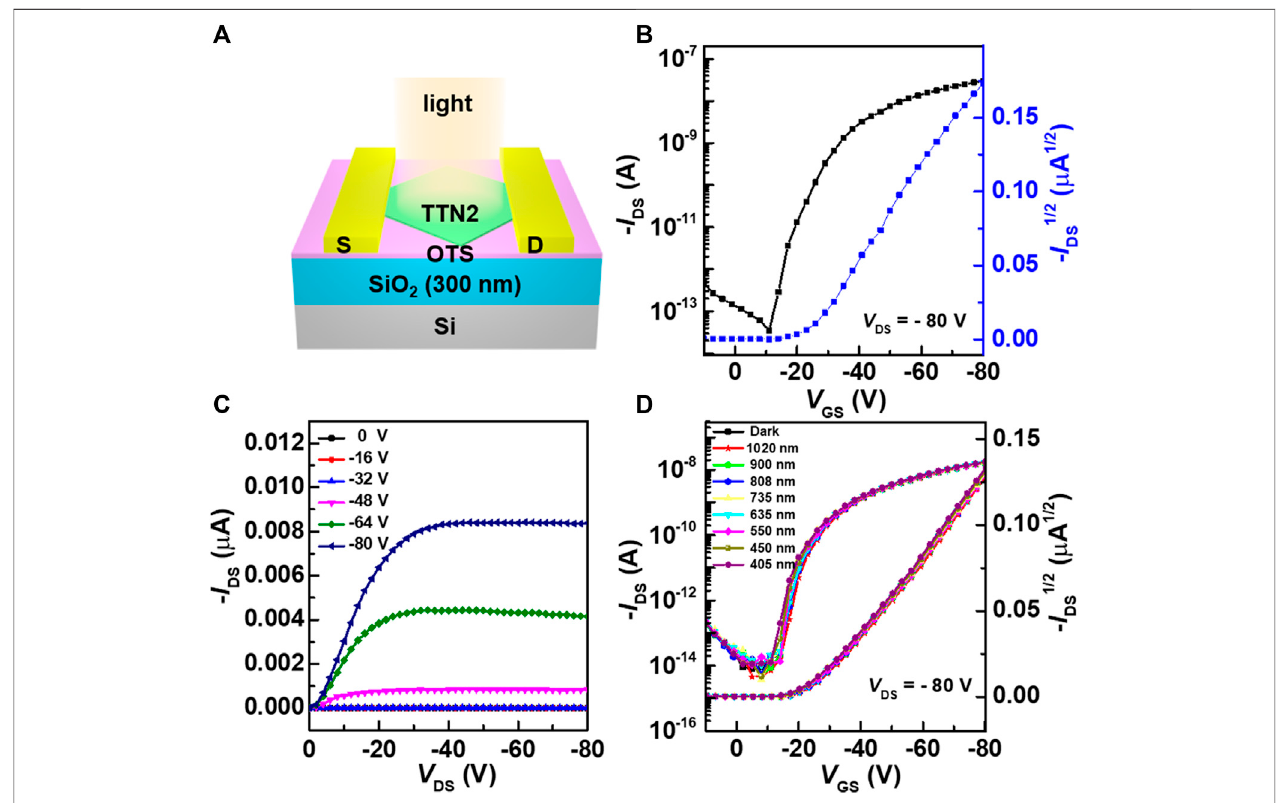
FIGURE 4 | (A) Schematic diagram of a top-contact bottom-gate OFET (B, C) Typical transfer and output characteristic curves of the OFET. Channel length is 24 μ m, Channel width is 45 μ m (D) Photoresponse of the OFETs under laser irradiation of different wavelengths from 405 – 1,020 nm.